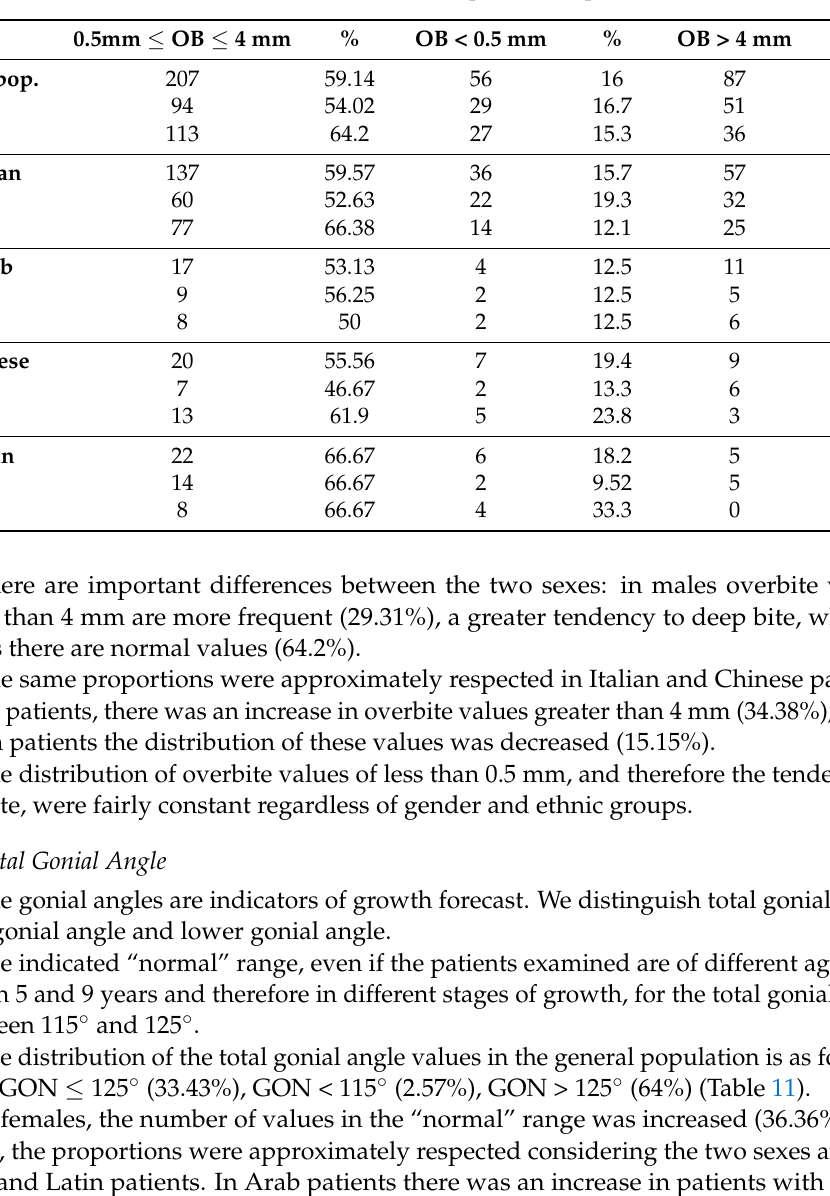
Table 10. Distribution of overbite values in the selected patient